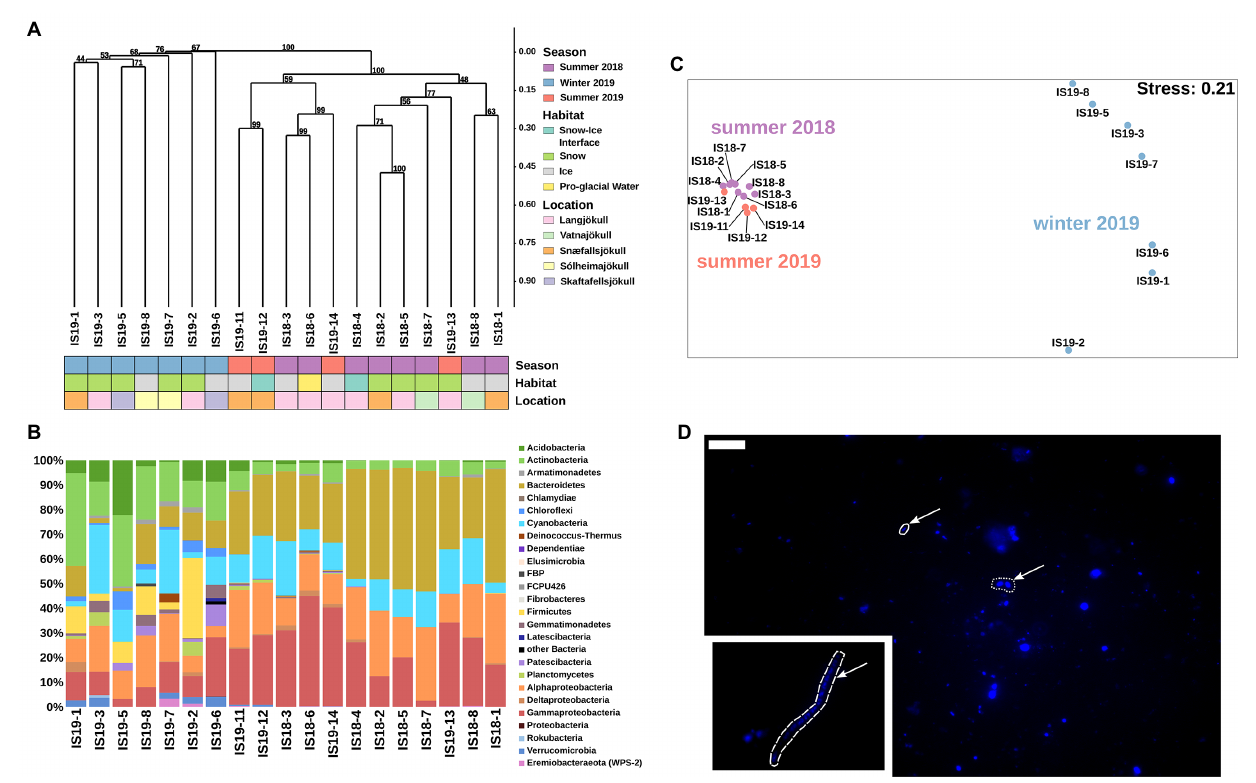
FIGURE 5 | Bacterial community structure based on 16S rRNA gene abundances. (A) Hierarchical clustering of 16S rRNA algae ASVs using Bray–Curtis and 1,000 iterations underlain by colored boxes that show season (red, purple, blue), locations (pink, orange, cyan, light purple, light yellow), and habitats (light blue, green, gray, yellow). (B) Stacked barplots showing 16S rRNA gene ASVs relative abundances at the class level. Bars have been ordered according to hierarchical clustering. (C) NMDS plot of 16S rRNA gene ASVs using Bray–Curtis dissimilarities of Hellinger transformed ASVs with sampling sites color coded per season as shown in legend in (A) . (D) Microscopic images of DAPI-stained cells. Arrow points toward different cell morphologies: solid = rod, dotted = coccoid, and dashed = filamentous. Scale bar represents 10 μ m. Direct imaging of DAPI-stained cells using epifluorescence microscopy revealed a range of microbial morphologies from cocci, and rod-shaped cells ( (D) , arrows in main image) to filaments ( (D) ,